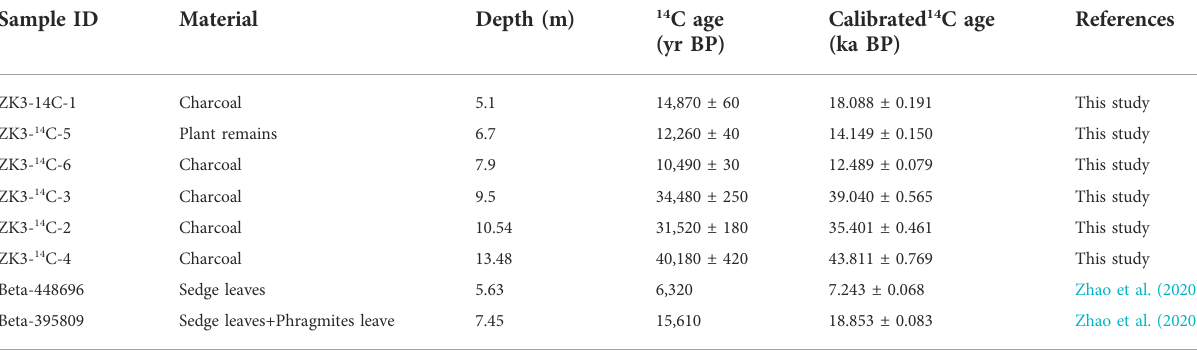
TABLE 2 AMS- 14 C dating of shallow sediments from the Ruoergai